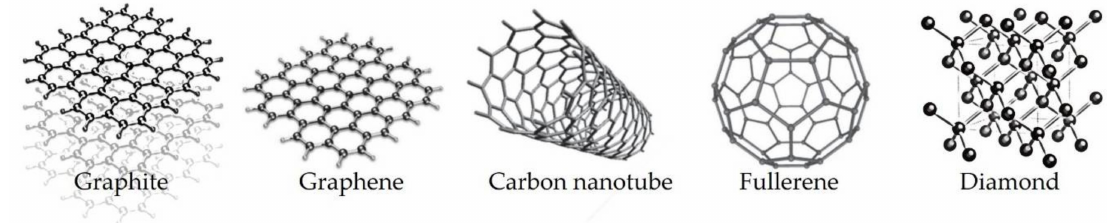
Figure 3. Carbon allotropes: Graphite (3D), Graphene (2D), CNT (1D), Fullerene (0D) and Diamond